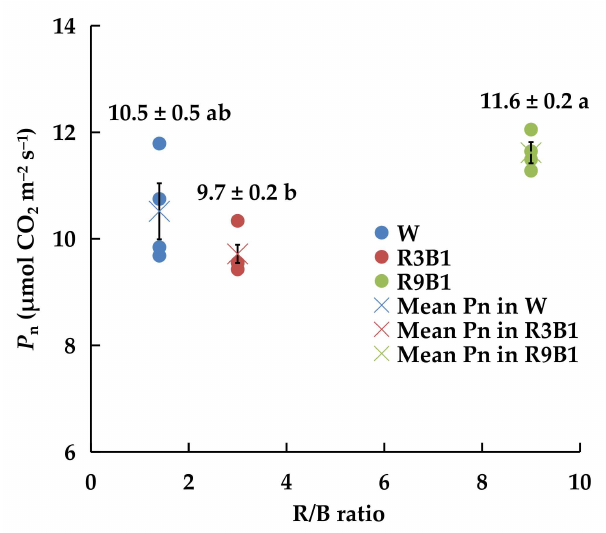
Figure 5. Effect of light quality on Pn of leaves in ‘Micro-Tom’ 10 DAT in Experiment 2. Four plants were measured for each PPFD. Solid point denotes the measured value for one plant. X-mark represents the average Pn of four plants in each treatment. Error bars represent ± standard error. Different letters indicate significant differences among the treatments based on Tukey − Kramer’s test at p < 0.05 ( n = 4). W: white light; R3B1: red/blue ratio = 3; R9B1: red/blue ratio =